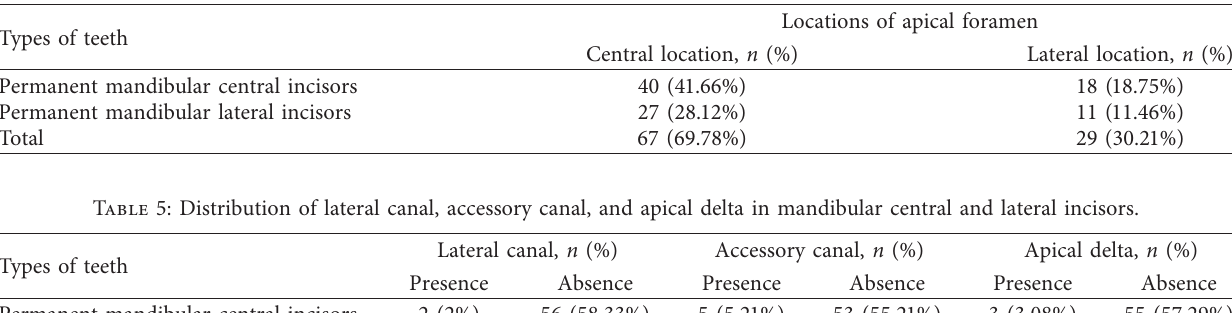
Table 4: Locations of apical foramen in mandibular central and lateral incisors.